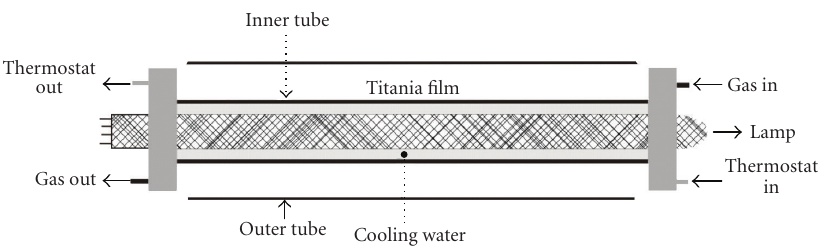
Figure 3: Schematic drawing of the